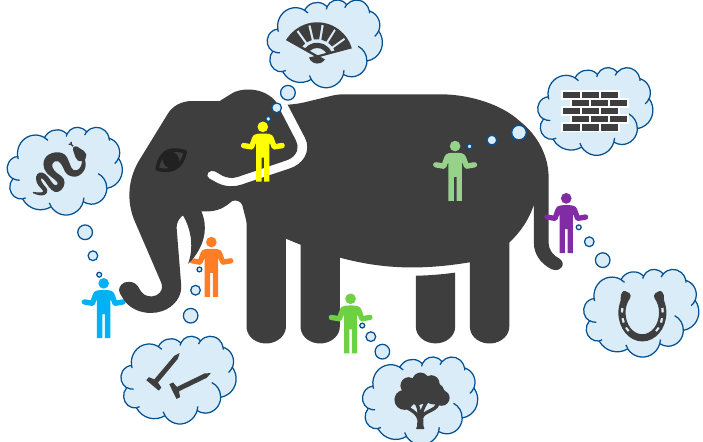
Figure 1. The parable of the blind men and the elephant (amended from a Hindoo parable)—It feels like a snake; it feels like a spear; it feels like a fan; it feels like a tree; it feels like a wall; no, it feels like a rope!. The picture was amended, developed and drawn by the authors.